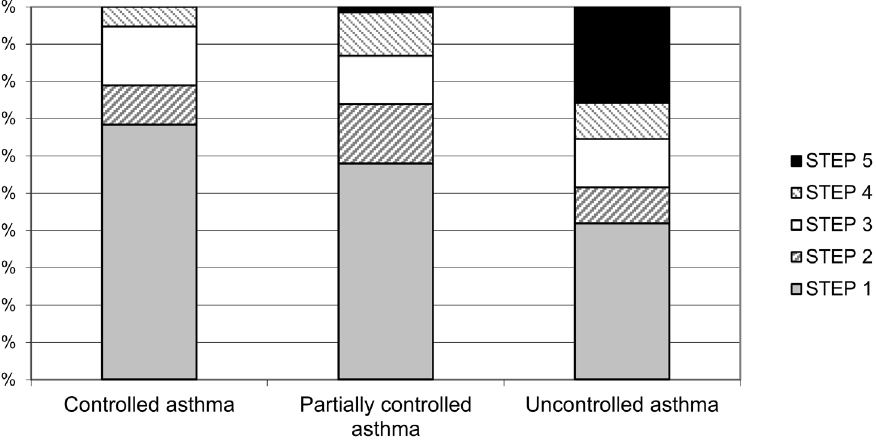
Figure 2. Distribution of treatment step* according to GINA classification in subjects with controlled asthma, partially controlled asthma and uncontrolled asthma, at follow-up. * STEP 1: As needed short-acting b 2 -agonist; STEP 2: Sustained release theophylline OR Leukotriene modifier OR Low-dose Inhaled Corticosteroids (ICS); STEP 3: Low-dose ICS plus long-acting b 2 -agonist OR Low-dose ICS plus leukotriene modifier OR Low-dose ICS plus sustained release theophylline OR Medium or high dose ICS; STEP 4: Medium or high dose ICS plus long-acting b 2 - agonist OR Medium or high dose ICS plus leukotriene modifier OR Medium or high dose ICS plus sustained release theophylline; STEP 5: Oral corticosteroids or Anti-IgE treatment.